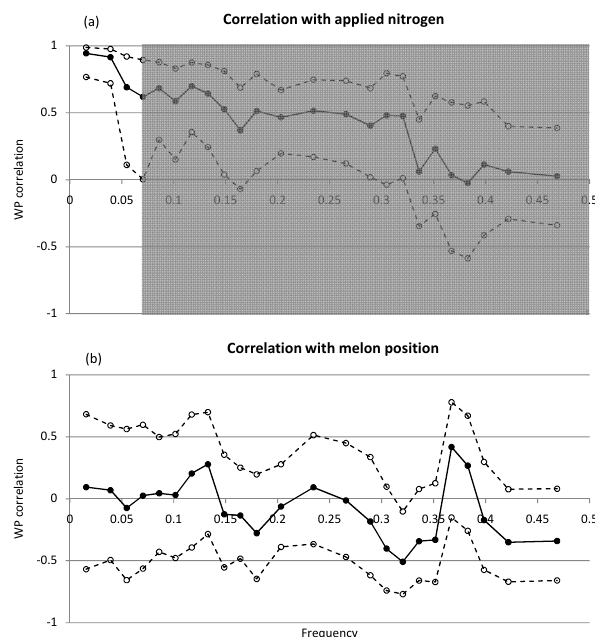
Fig. 8. The solid symbols show the wavelet packet correlations be- tween (a) applied nitrogen and wheat biomass, and (b) melon posi- tion and wheat biomass plotted against the mid-point of the corre- sponding frequency interval. The 95% confidence interval for each estimate are shown by the open symbols. The solid and dotted lines that join the symbols are to aid visual interpretation. In Figure (a) the WP correlations at frequencies larger than 0.0625 are greyed out because there is negligible variation in applied nitrogen at these higher frequency packets (as can be seen in Fig.